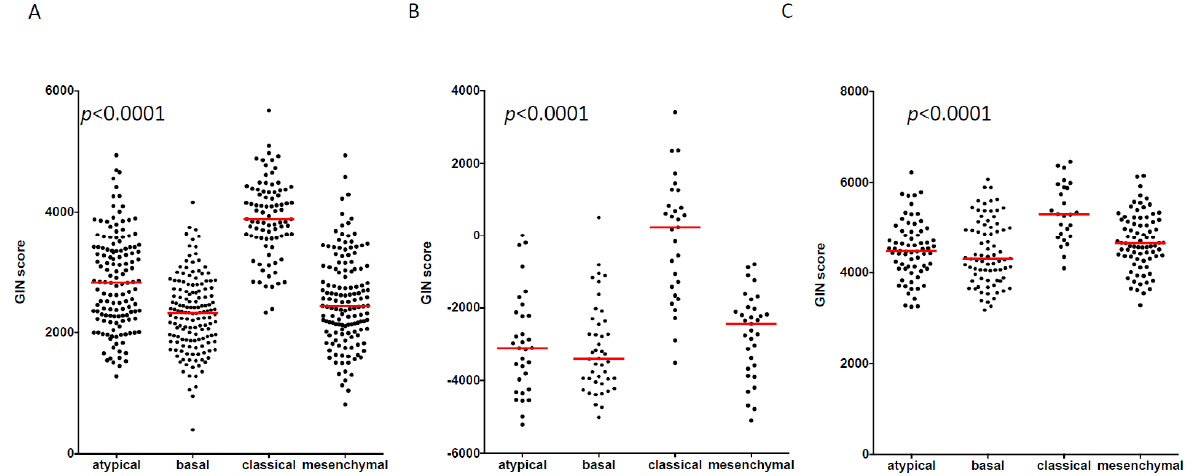
Figure 2. Association of GIN score with molecular classification of HNSCC. GIN score was computed in 520, 138, and 253 HNSCC from TCGA ( A ), GSE39366 ( B ), and GSE65558 ( C ) respectively. In all 3 datasets, GIN score was compared among the four previously described molecular subtypes (At: atypical; Ba: basal; Cl: classical; Me: mesenchymal) using a Kruskall–Wallis test. p -value is shown.